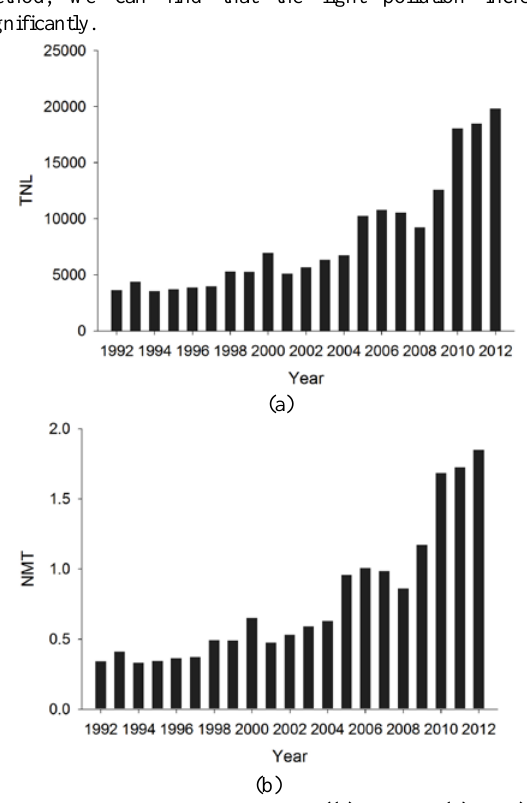
Figure 5. The night-time light index ((a)TNL and (b)NMT)of XGNSPA from 1992-2012